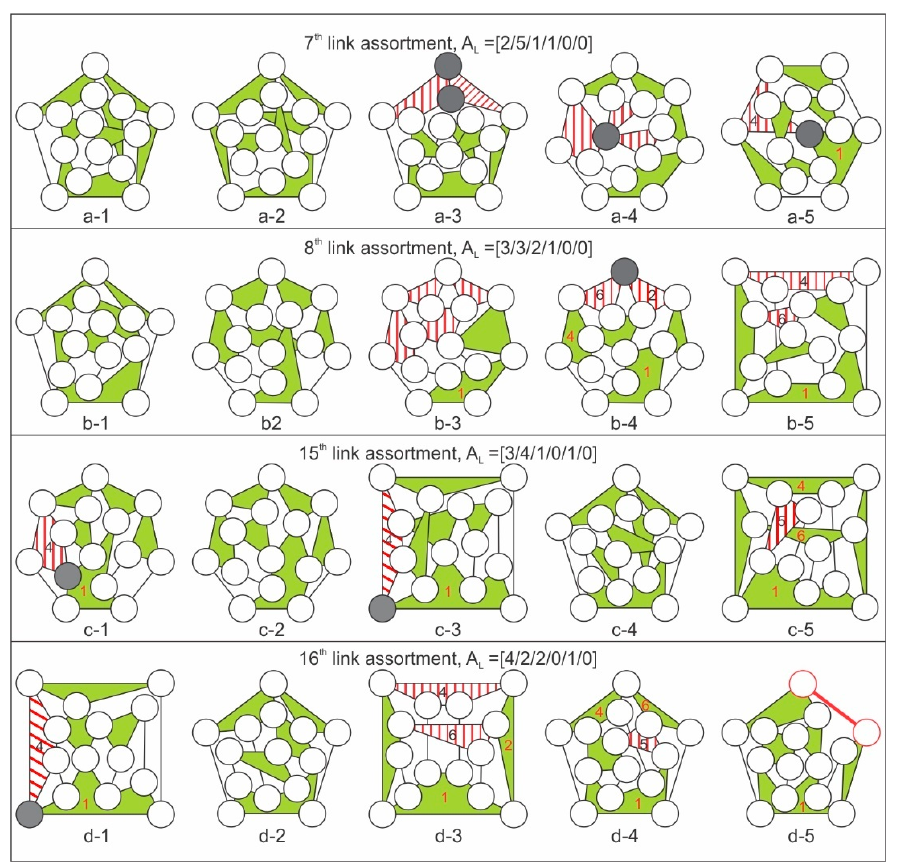
Figure 5. Illustrative GKCs with 7th, 8th, 15th and 16th link assortments.